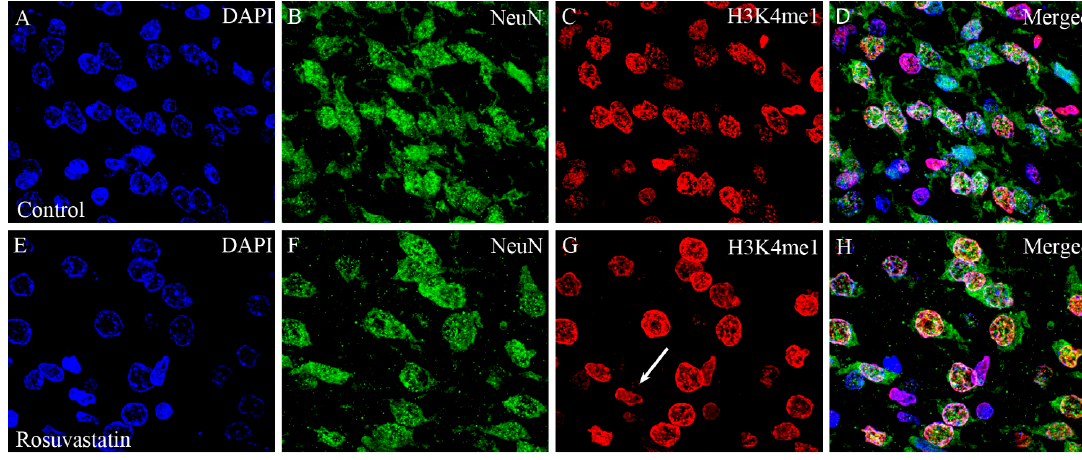
Figure 8. Laser confocal microscopy images of H3K4me1 and H3K4me3 immunoreactivities in neuronal nuclei. Paraffin sections of brains from the control ( A – D , I – L ) and RST-treated newborn rats ( E – H , M – P ) were immunostained for NeuN (shown here in green) and H3K4me1 or H3K4me3 (shown here in red), then visualized by confocal microscopy. Cell nuclei were labeled with DAPI (blue). Note the overwhelmingly neuronal localization of the histone methylation marks. Some NeuN-negative non-neuronal cells, notably in panels ( G , K ) (white arrows), also display H3K4me1 and H3K4me3 marks. Scale bar: 20 µm.